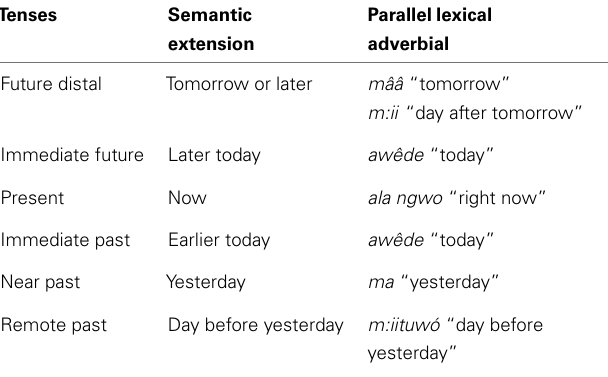
Table 3 |The meanings of the tenses and the correlated temporal adverbials labels for tenses come from Henderson (1995).